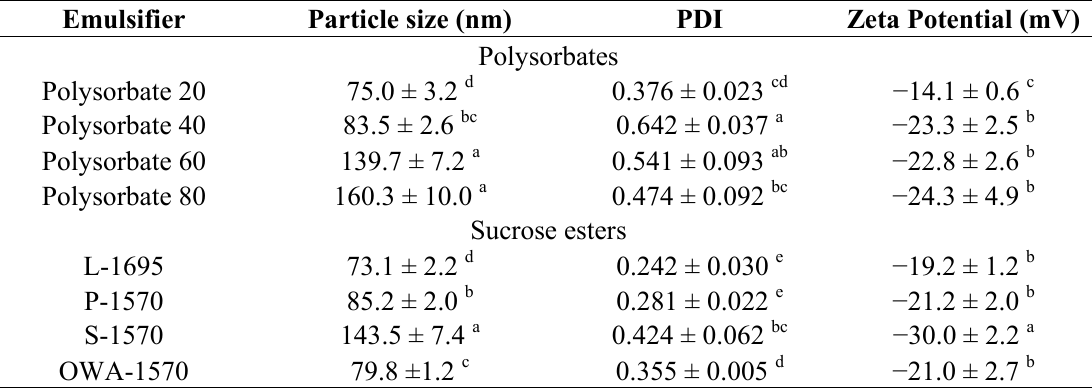
Table 2. Average particle size (nm), PDI and zeta potential of astaxanthin nanodispersions prepared with different emulsifier.